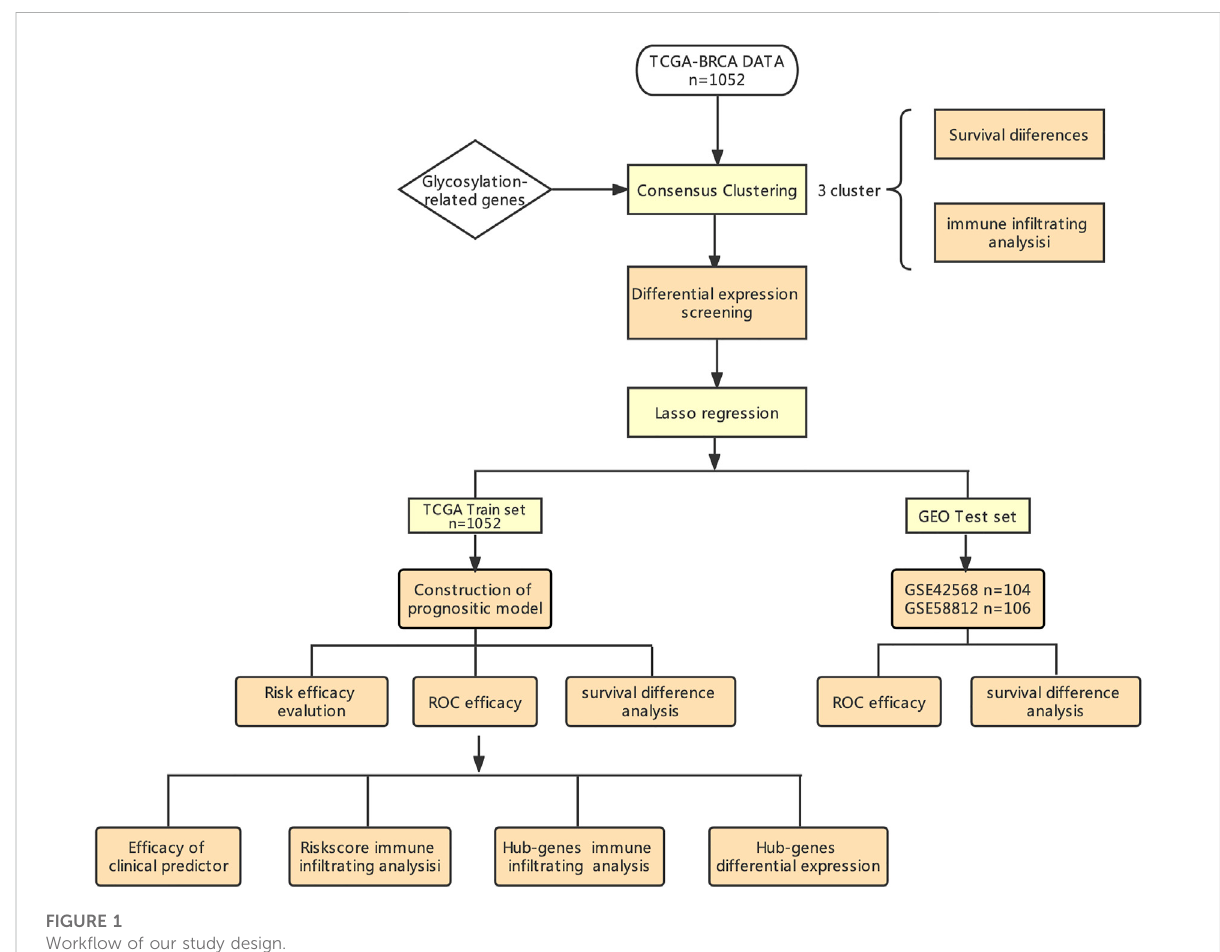
FIGURE 1 Work fl ow of our study